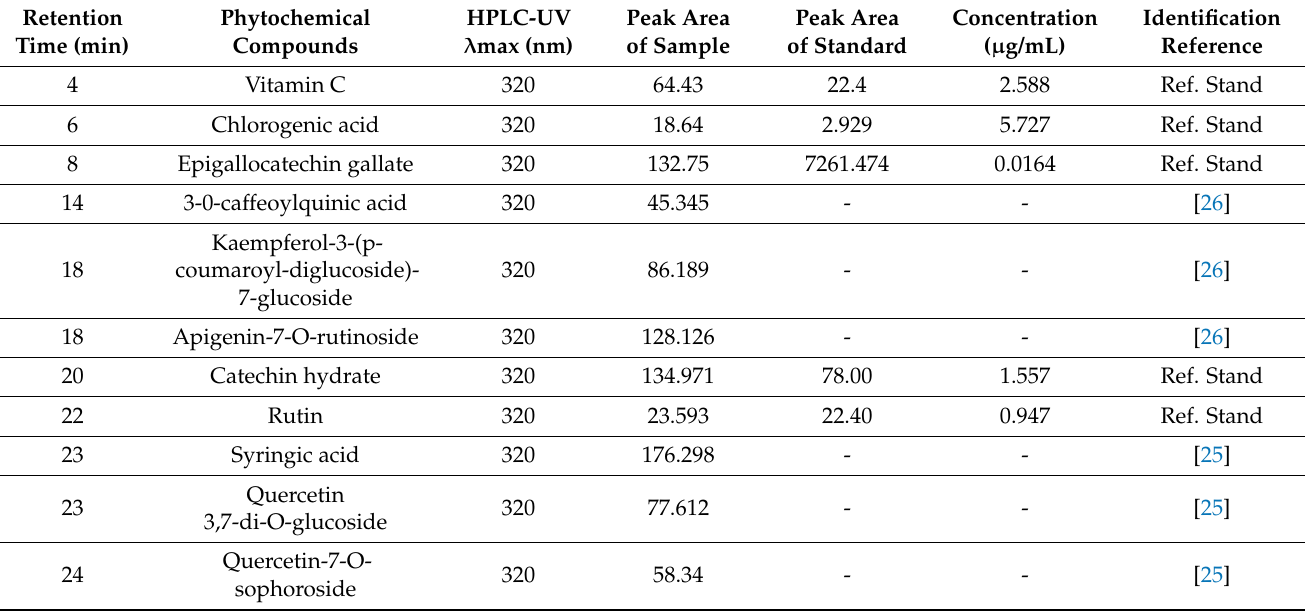
Table 3. Identified phytochemical compounds in fraction A of A. articulata through the HPLC-UV